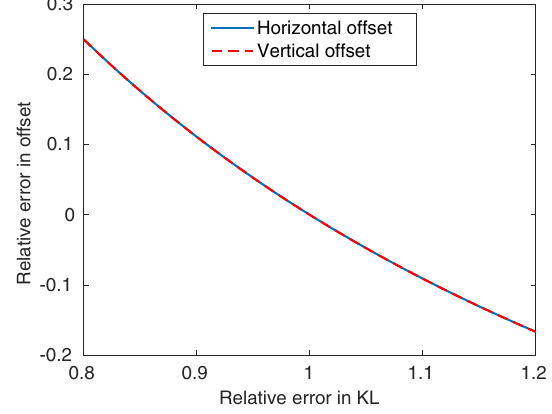
FIG. 2. Relative error in fitted offset for different systematic errors in KL .